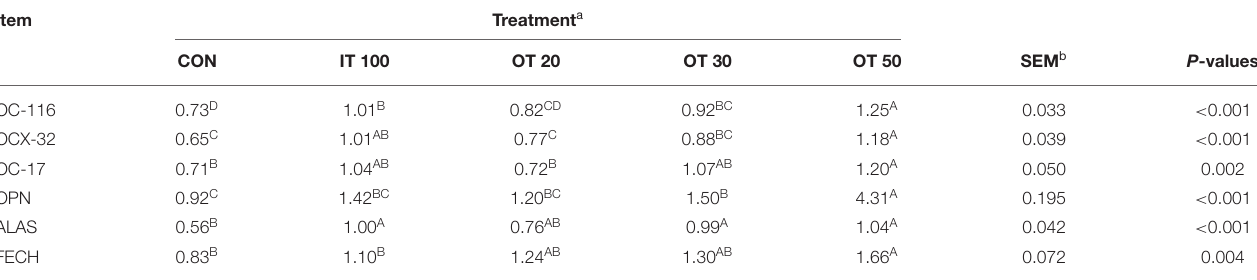
TABLE 6 | Effects of inorganic and reduced substitution of organic trace minerals on gene expression of eggshell gland at the 8th week of the experiment with hen layer at the age of 67 weeks.